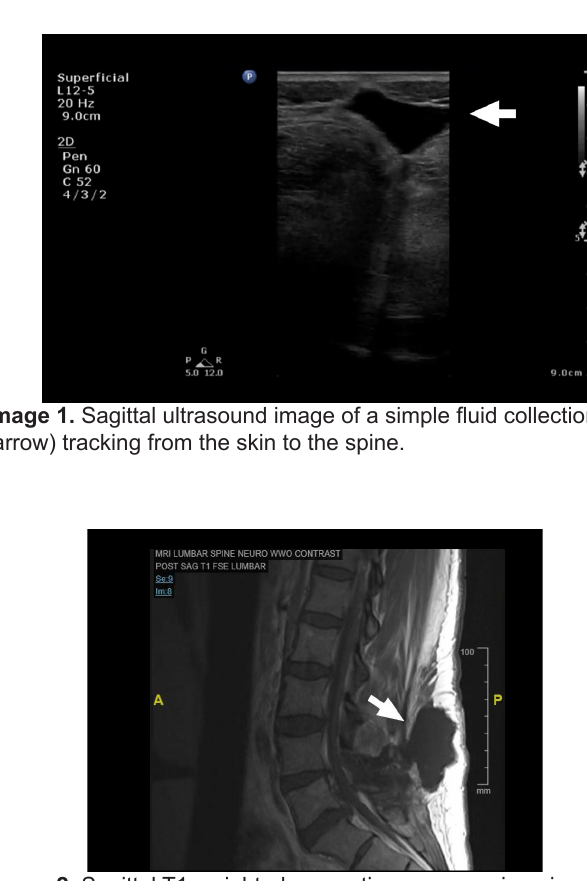
Image 2. Sagittal T1-weighted magnetic resonance imaging of the lumbosacral spine demonstrating the pseudomeningocele (arrow) identified initially on